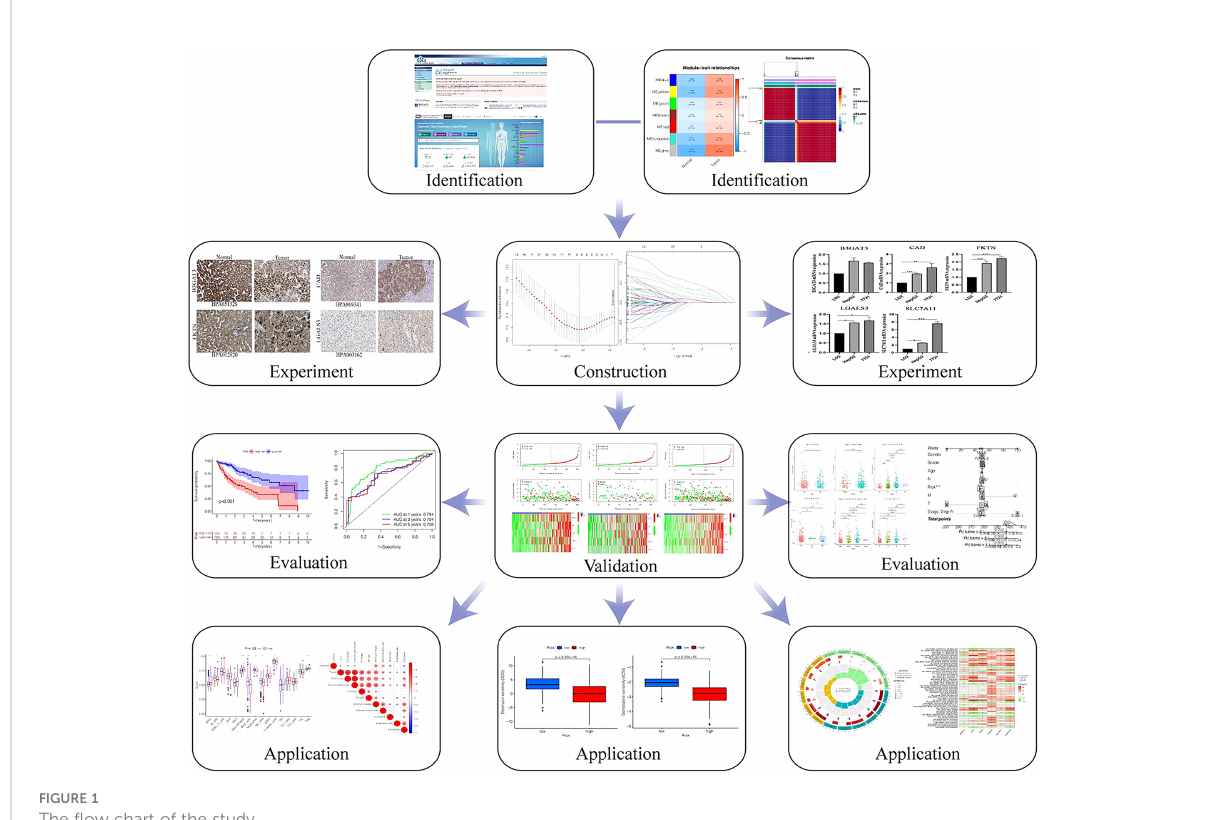
FIGURE 1 The fl ow chart of the